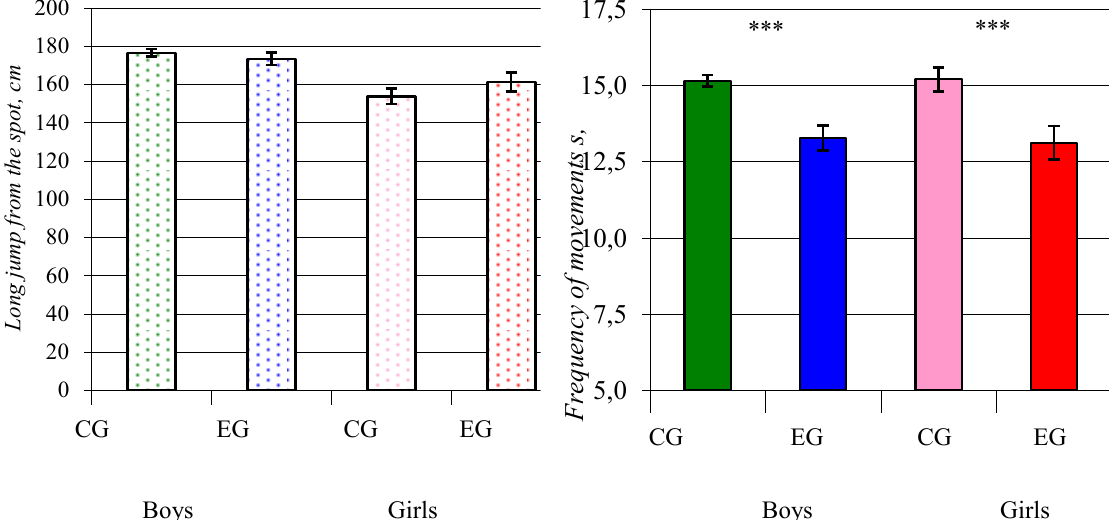
Fig.2 Explosive power and movements’ frequency of countryside teenagers of 7 th form in control (CG) and experimental (RG) groups after forming